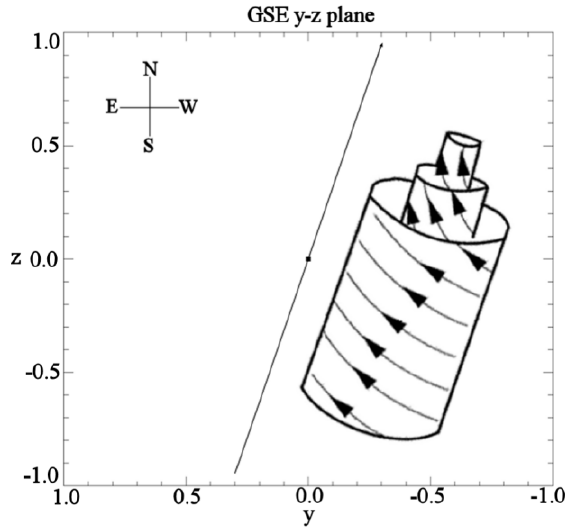
Fig. 3. The orientation of the magnetic cloud obtained from per- forming a minimum variance analysis over the cloud duration is illustrated in the y-z GSE plane. The axial field is mainly in the positive z GSE (northward) direction, whilst the rotation of the MC is mainly in the y GSE direction, rotating positive to negative (east to west). This indicates that the MC is left-handed and the sign of he- licity of the MC is negative. (Adapted from Bothmer and Schwenn,